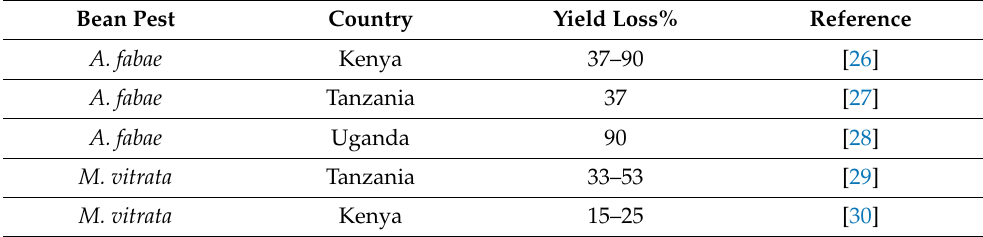
Table 1. the empirically assessed bean yield losses attributed to black bean aphid ( Aphis fabae ) and bean pod borer ( Maruca vitrata ) in East African countries per year. Table 1. Cont .